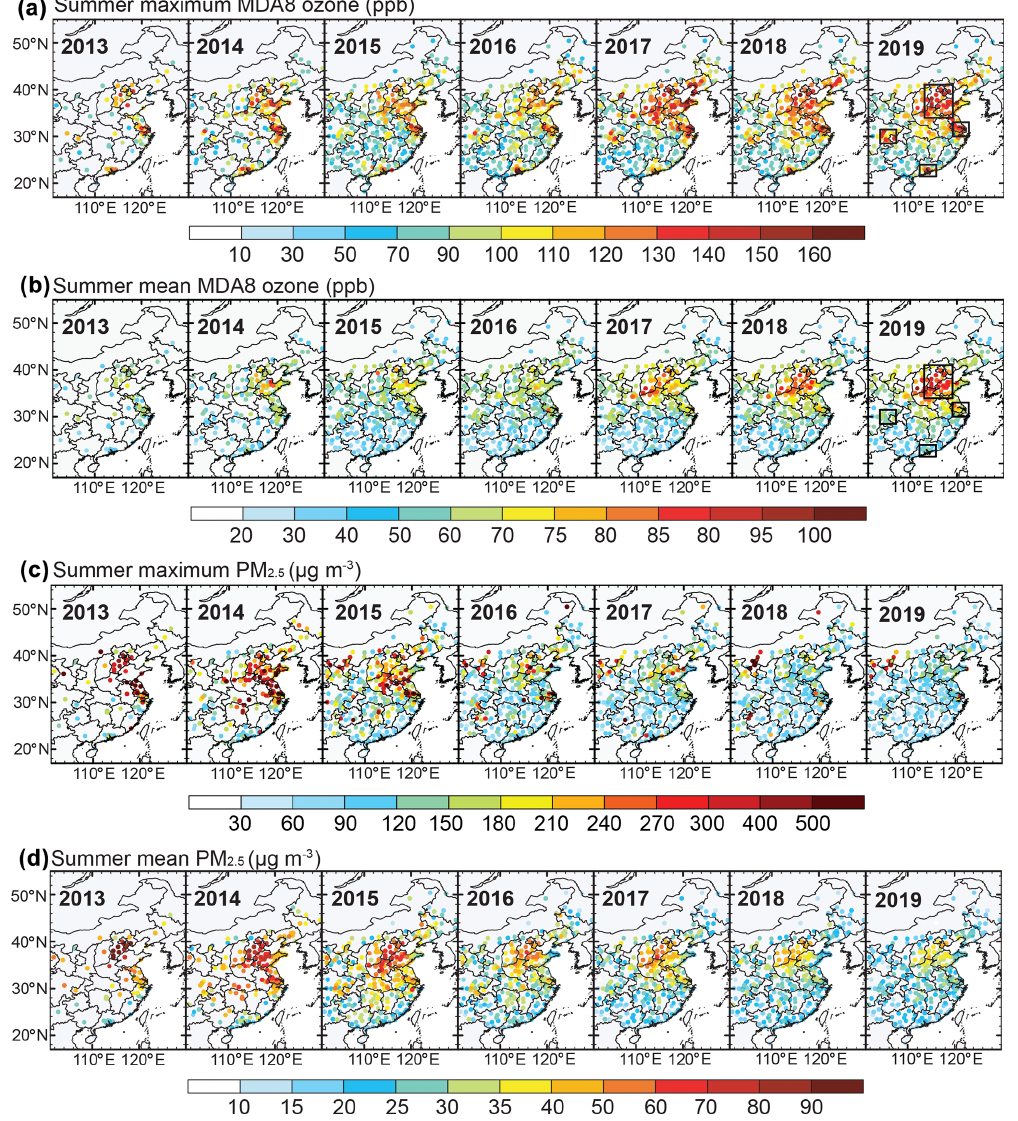
Figure 1. Summer (JJA) concentrations of maximum MDA8 ozone (a) , mean MDA8 ozone (b) , maximum PM 2 . 5 (c) , and mean PM 2 . 5 (d) for 2013–2019 at the network operated by the China Ministry of Ecology and Environment (MEE). Rectangles denote the four megacity clusters discussed in the text: the North China Plain (NCP; 34–41 ◦ N, 113–119 ◦ E), the Yangtze River Delta (YRD; 30–33 ◦ N, 119–122 ◦ E), the Pearl River Delta (PRD; 21.5–24 ◦ N, 112–115.5 ◦ E), and the Sichuan Basin (SCB; 28.5–31.5 ◦ N, 103.5–107 ◦